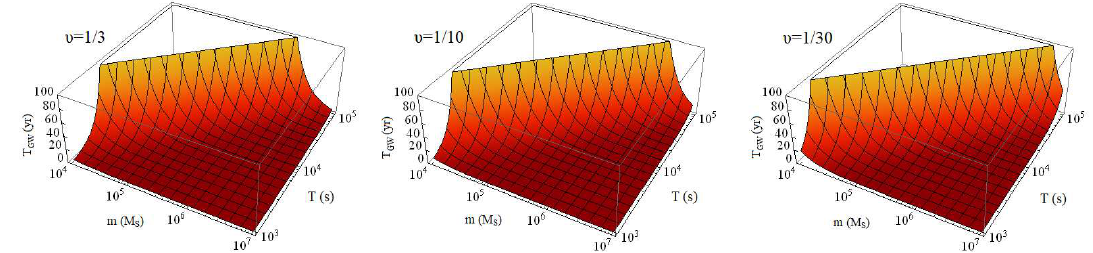
Figure 1. The gravitational lifetime of a binary T GW as function of the total mass m and orbital period T , for choices of mass ratio ν = 1/3 (left-sided panel), ν = 1/10 (middle panel), ν = 1/30 (right-sided